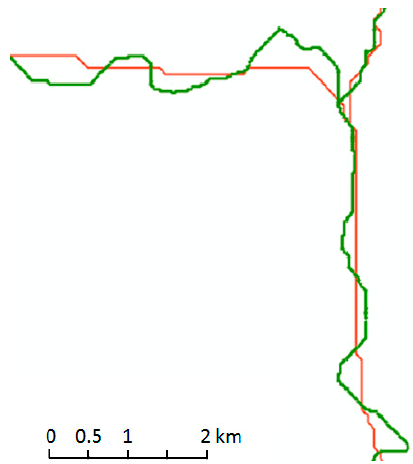
Figure 9. Detail of the hydrographic network extracted from SRTM (red) and Topodata (green). Source: [108].